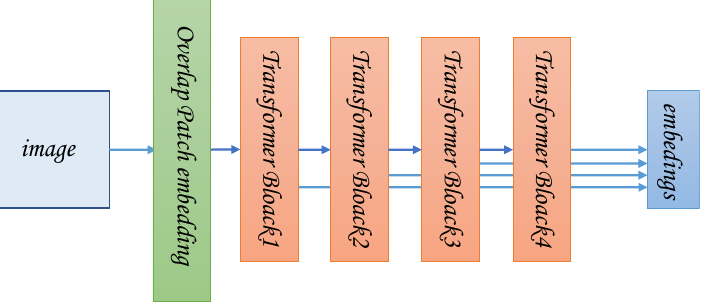
Figure 7. Multi-scale Feature